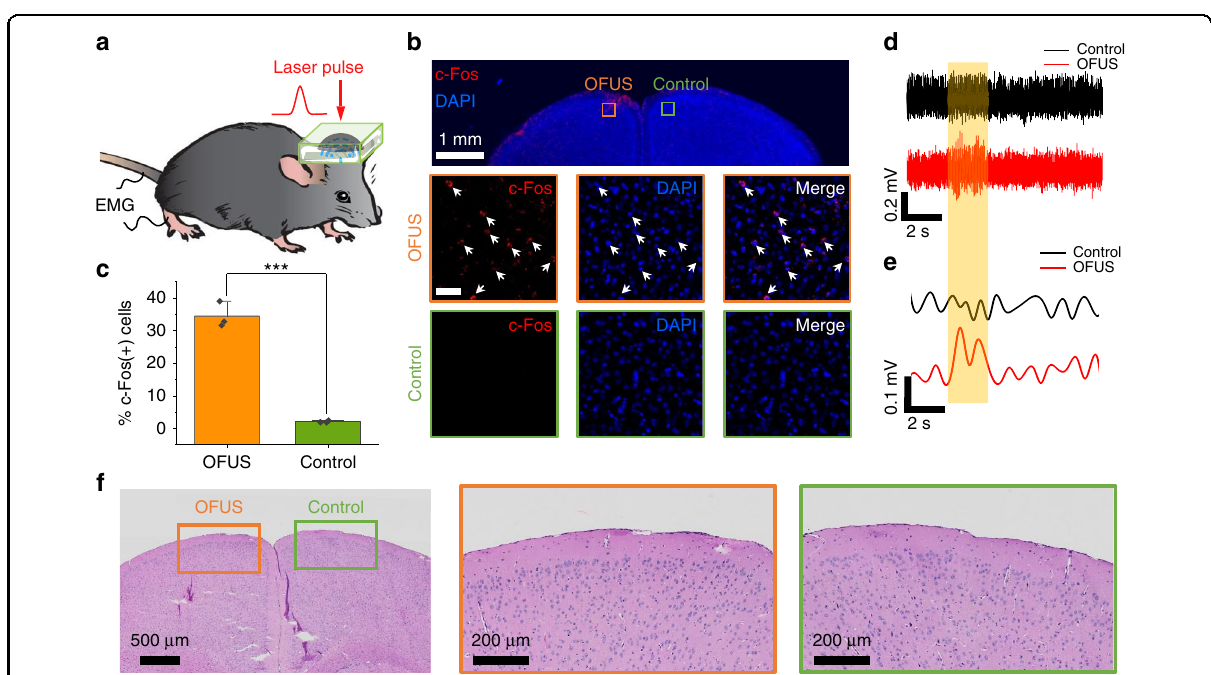
Fig. 5 Representative immuno fl uorescence examinations and EMG recording trace for in vivo OFUS stimulation. a The schematic of OFUS stimulation in vivo. b Representative images of c-Fos and DAPI staining within the stimulation and control area. Red: c-Fos. Blue: DAPI. Orange outline: OFUS stimulated area. Green outline: control group at the contralateral area. Scale bar: middle and lower panel, 50 μ m. c Statistic analysis of the percentage of c-Fos positive neurons. *** p < 0.001, two-sample t-test. d Representative EMG recordings of 2 s OFUS stimulation and control group targeting the somatosensory cortex. Orange box: laser on. e EMG signals after the band-pass fi lter and full-wave recti fi er and